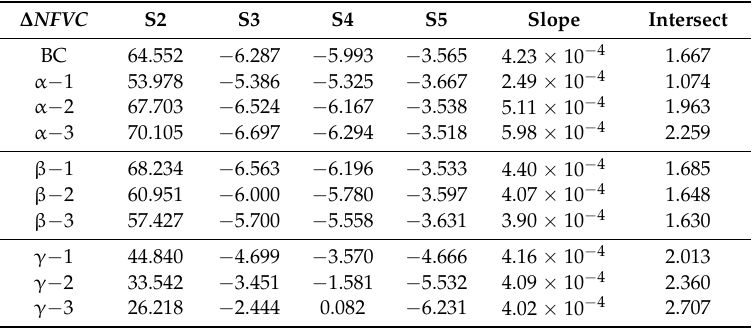
Table 3. % error introduced by the linear approximation in the incremental curve of non-fuel variable costs ( NFVC